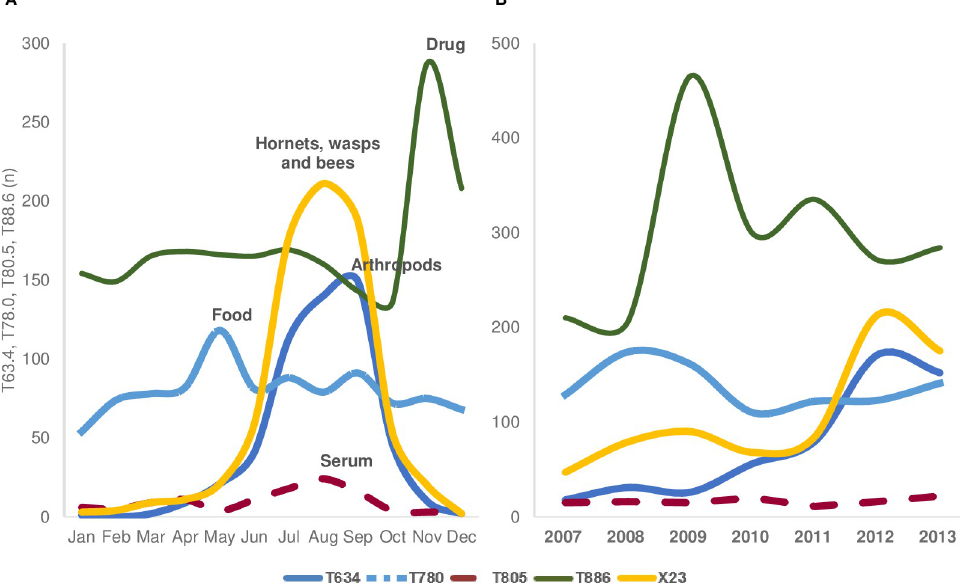
trend from 2010 (Fig 5B). The arthropods and bee stings were highest in 2012 (Fig 5B). In children aged > 7 years and in adults, drugs were the most common cause of anaphylaxis (Fig 7). By the age of 19, food accounted for 30.4% of anaphylaxis, and after the age of 20, the frequency of food anaphylaxis gradually decreased. for 15.1%. The second most frequent cause was food (7.6% of patients aged < 1 year and 9.0% of patients aged between 1 and 6 years).